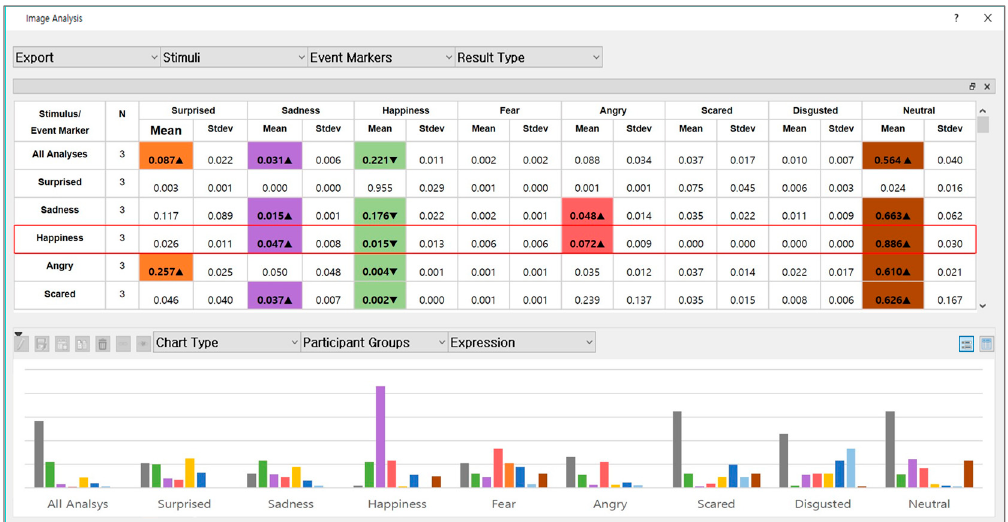
Figure 16. The real-time interview management system. * The figure included in this image is the author, who agreed to provide the figure.